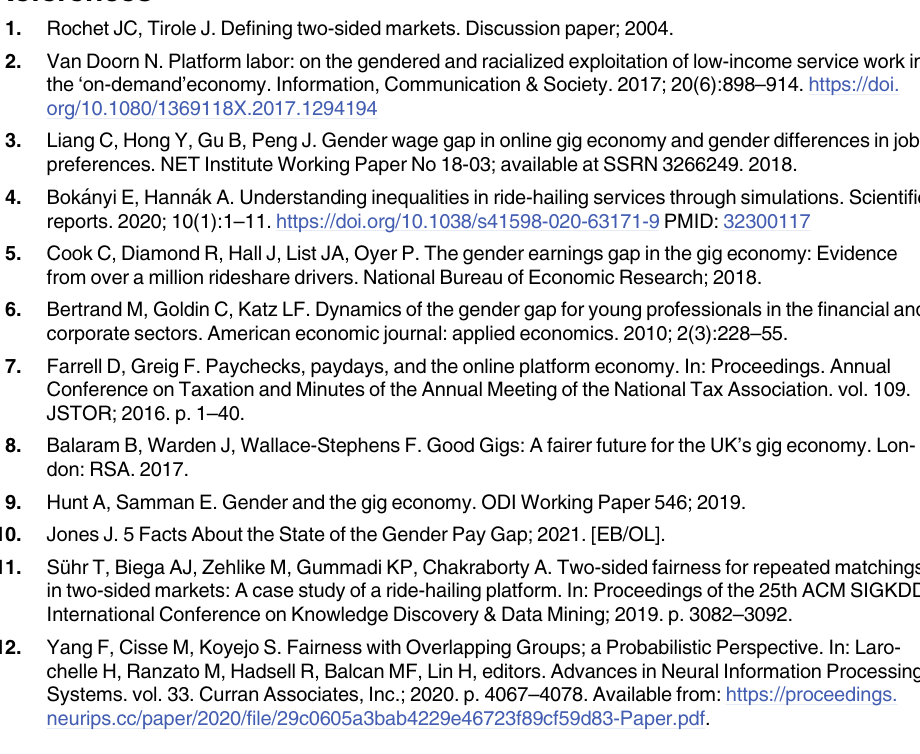
S3 Fig. As an analogy to the 5-fold cross validation in S1 Fig, the same implementation is repeated with 10-fold. We show the trade-off plots of 10 new